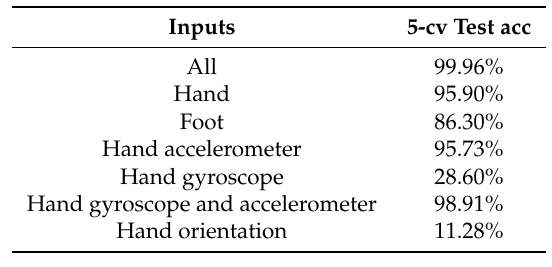
Table 5. Comparison of 5-fold cross validation test accuracy for different combinations of sensors, with T = 4 s and γ = 0.95.